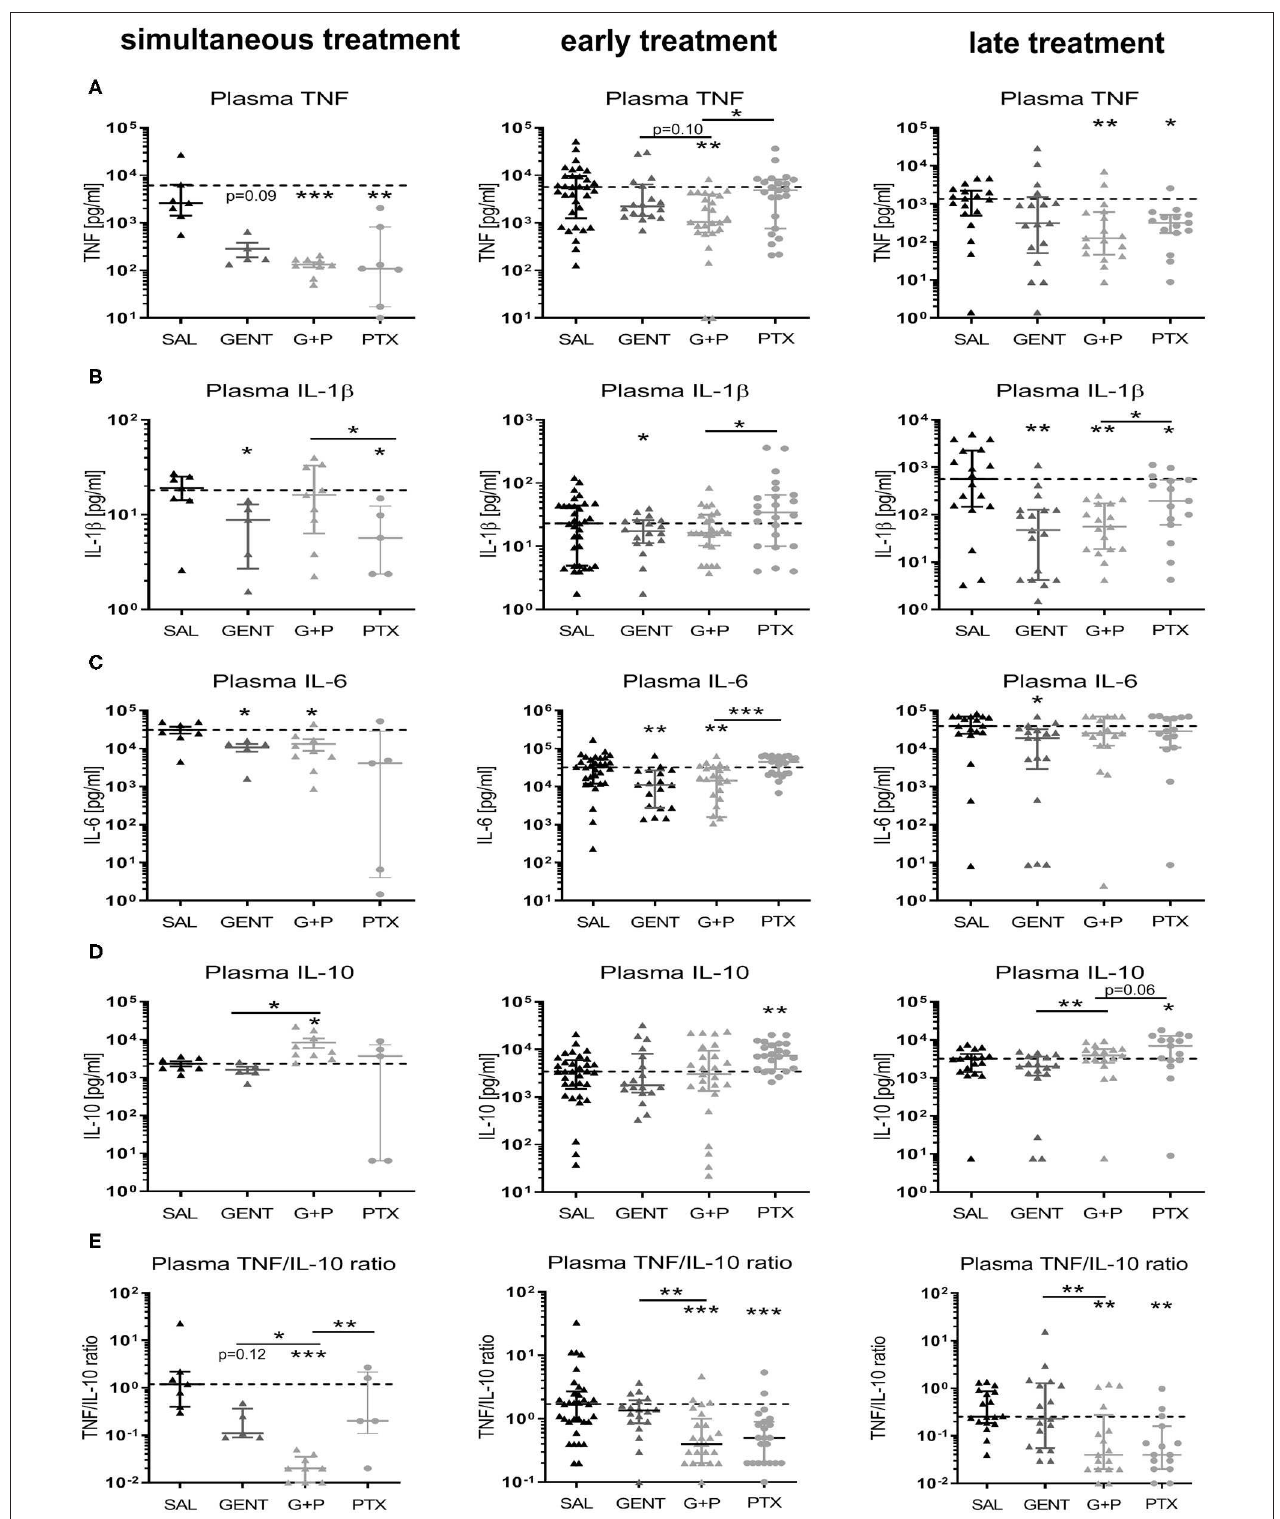
FIGURE 9 | Addition of PTX to GENT profoundly inhibited E. coli -induced plasma TNF and enhanced plasma IL-10 in septic newborn mice. Neonatal mice < 24h old were injected IV with E. coli 10 5 CFU/g body weight, followed by simultaneous (0h, n = 7–9), early (1.5h, n = 18–33), or late (4h, n = 15–18) IP injection of SAL, GENT, PTX, or GENT + PTX (G + P). After an additional 4h of incubation, i.e., 4, 5.5, or 8h from the time of sepsis initiation, mice were euthanized and plasma